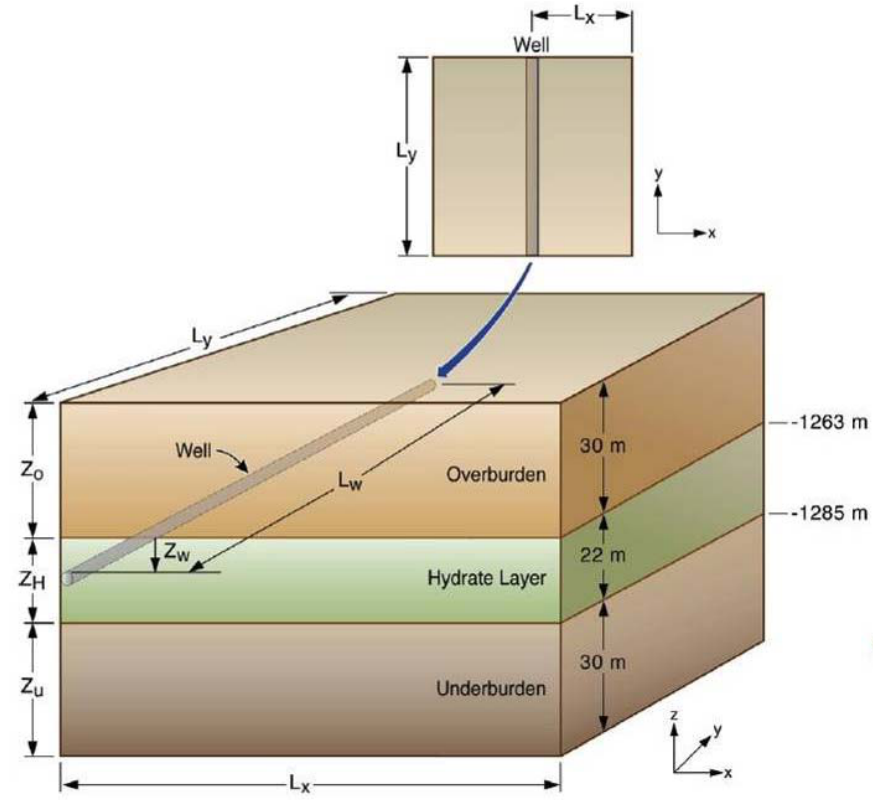
Figure 2. System geometry and configuration of the horizontal well producing from the hydrate deposit at the SH7 site of the Shenhu Area, South China